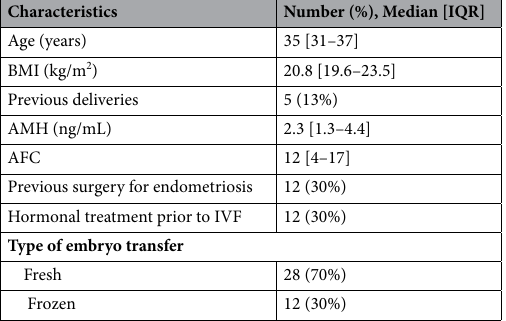
Table 1. Baseline characteristics of the included women (n = 40). One woman was included twice. IQR interquartile range, BMI Body Mass Index, AMH anti-mullerian hormone, AFC antral follicle count.